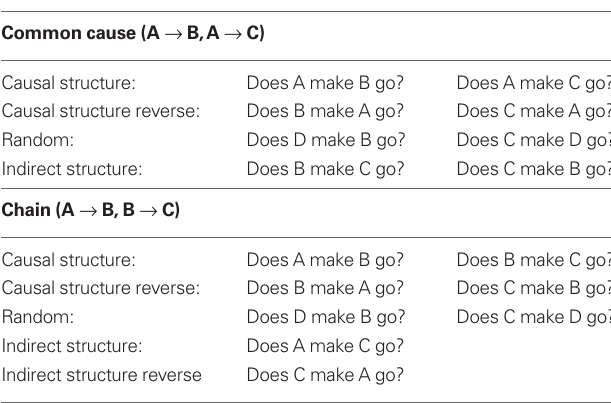
Table 1 | exact test questions asked in